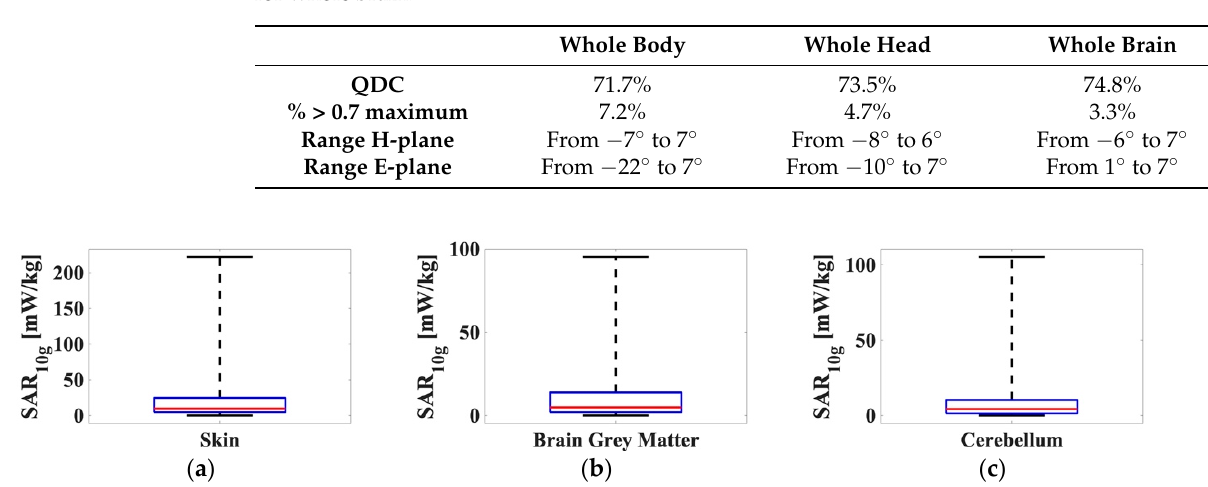
Table 2. The QDC values, the percentage of SAR values higher than the 70% of the maximum values, and the corresponding ranges of elevation and azimuth angles for whole body, for whole head, and for whole brain.